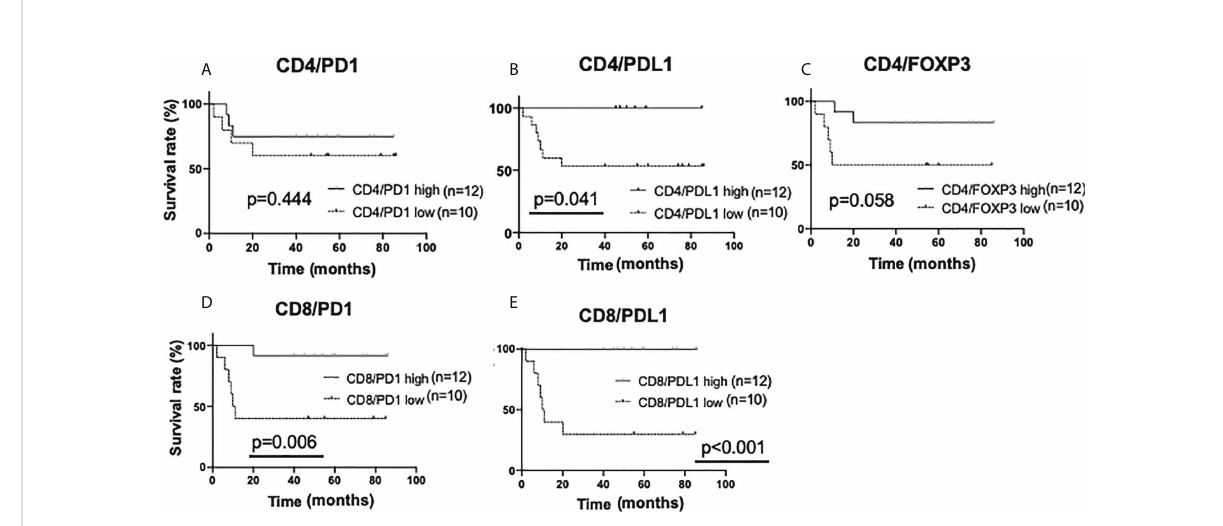
FIGURE 7 Kaplan-Meier analysis for recurrence-free survival categorized by the amount of intratumoral TIL (iTIL) marker double-positive cells in triple- negative cases. In TN subtypes (n=22), each sTIL marker was classi fi ed into “ low ” (n=10) and “ high ” (n=12) and analyzed as follows. (A) CD4/PD1- double positive iTIL low; <15 cells, high; >=15 cells, (B) CD4/PDL1-double positive iTIL low; =<0 cells, high; >0 cells, (C) CD4/FOXP3-double positive iTIL low; <30 cells, high; >=30 cells, (D) CD8/PD1-double positive iTIL low; <30 cells, high; >=30 cells, (E) CD8/PDL1-double positive iTIL low; <6 cells, high; >=6